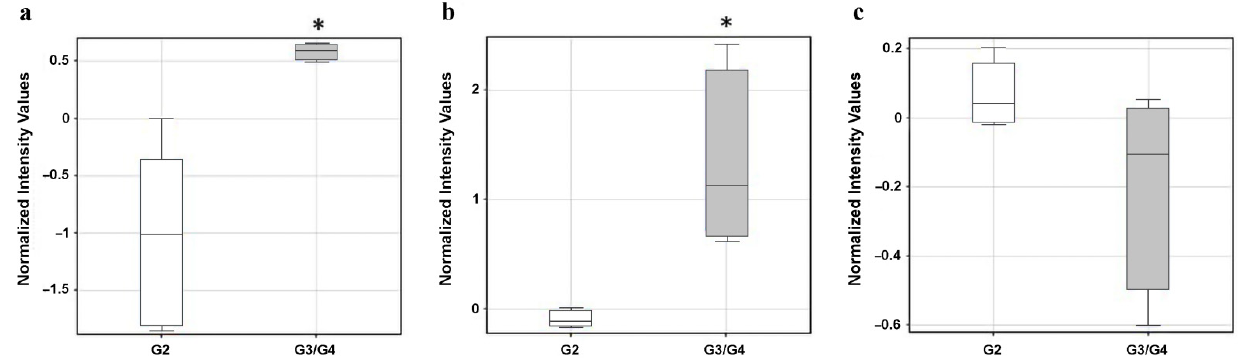
Figure 1. TGF β 1 ( a ); TGF β 2 ( b ) and TGF β 3 ( c ) expression profiles in relation to tumor grade ob- tained by oligonucleotide microarray. Results are presented as median with lower and upper —statistical statistical significance ( p <